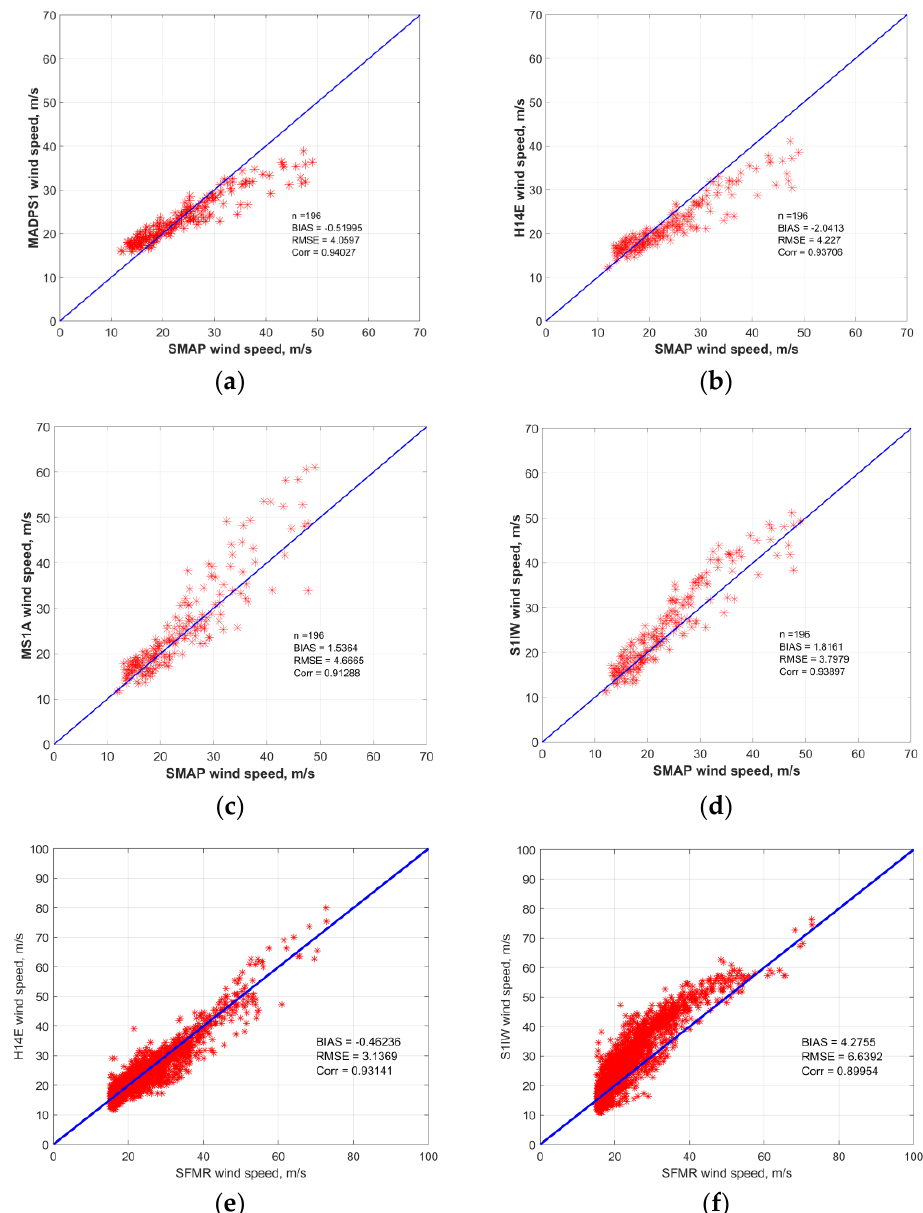
Figure 6. The dependencies of wind speed U 10 for all sub swaths on the wind speed retrieved from the SMAP measurements: MADP-S1 ( a ); H14 E ( b ); MS1A ( c ); S1IW.NR ( d ). n corresponds to the number of data points. The dependencies of wind speed U 10 for all sub swaths on the wind speed retrieved from the SFMR measurements (on the basis of the dataset from Table 1): H14 E ( e ); S1IW.NR ( f